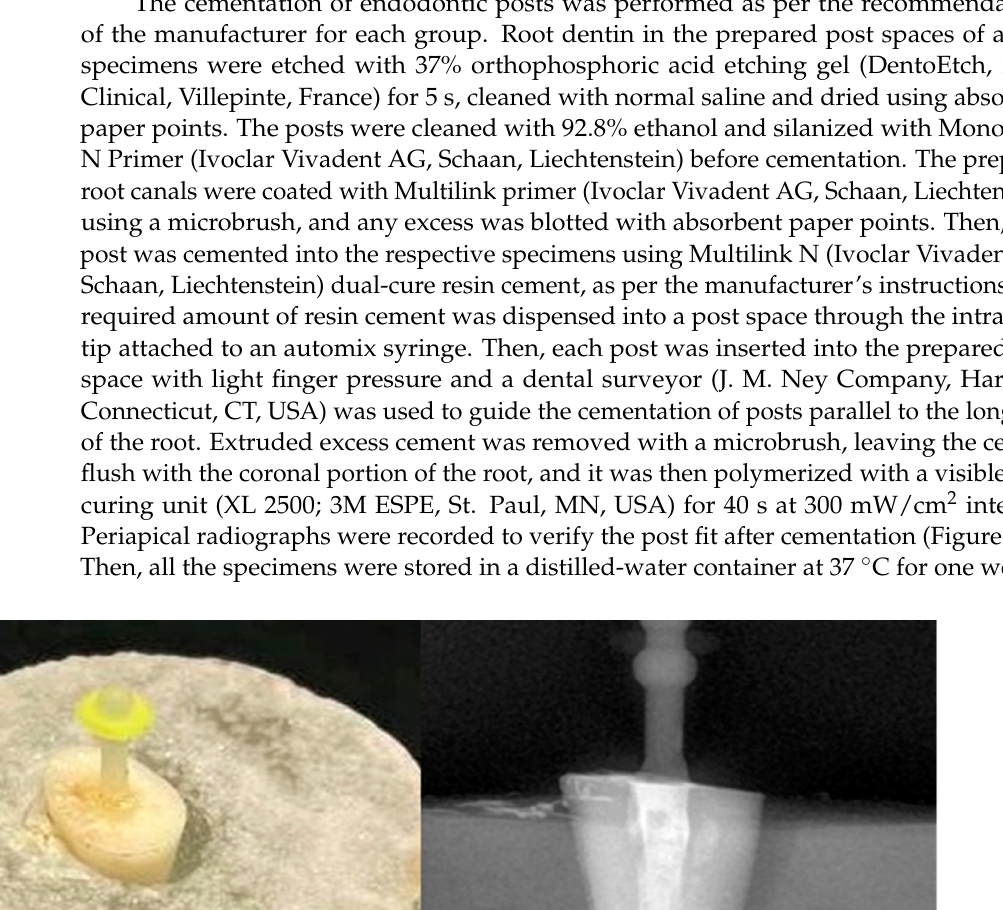
Figure 4. ( a ): Mounted specimen on Isomet precision machine for sectioning; ( b ): 4 mm slice of spec- imens obtained for push-out test. Push-out test: Each 4 mm thick slice was subjected to a push-out bond strength test using a univer- sal testing machine (Instron, model 8500 Plus; Dynamic Testing System; Instron Corpora- tion.; Norwood, MA, USA.) at a cell load of 50 kg and a crosshead speed of 0.5 mm/min